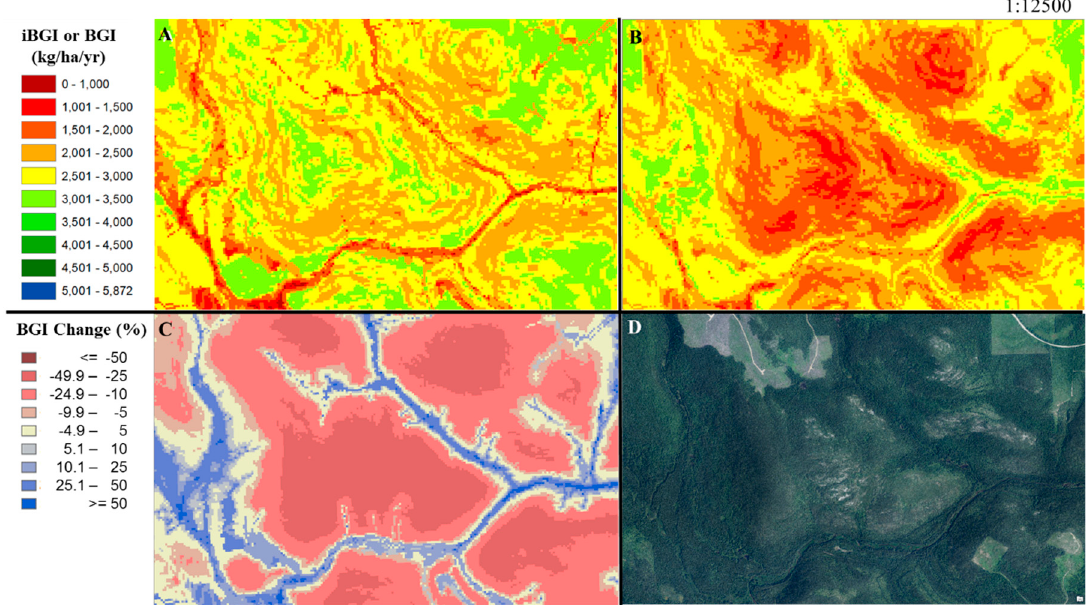
Figure 5. Fine resolution presentation of (A) base biomass growth index (BGI), (B) improved biomass growth index (iBGI), (C) the % difference [(iBGI – BGI) / BGI × 100] at (D), a sample area with central coordinates of 47.3°N, 66.3°W that is part of the highlands ecoregion in New Brunswick, and shows barren-rock-outcrop (greyish) ground. There was better classification of these poor sites in the iBGI mapping (B) compared to the base BGI map (A).